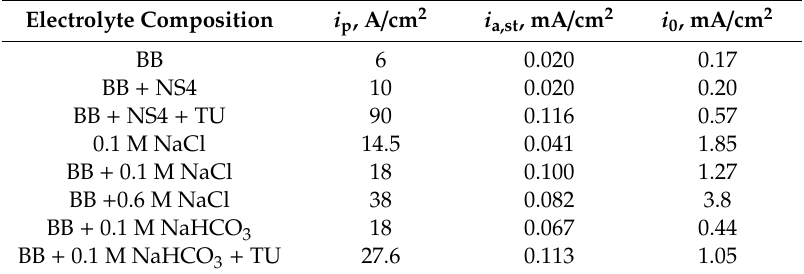
Table 3. The stationary rate of hydrogen penetration ( i p ) into steel at E = − 1 V (SHE), the stationary density of anodic current ( i a,st ) at E = − 0.3 V (SHE) and the anodic current density in 0.09 s after switching the potential ( i 0 ) under SACP with τ c = 10 min in solutions of various compositions. Electrolyte Composition i p , A / cm 2 i a,st , mA / cm 2 i 0 , mA / cm 2 BB 6